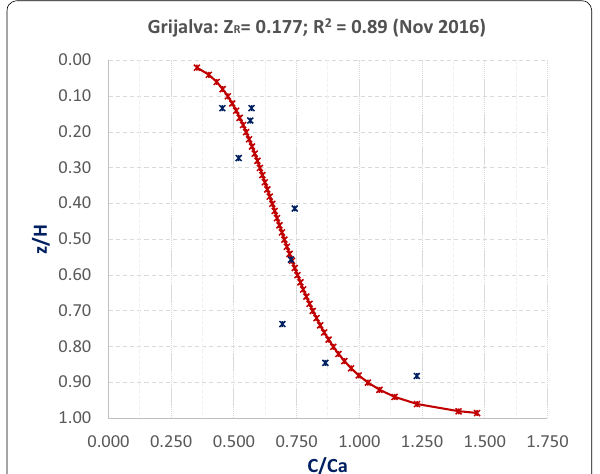
Fig. 5 Suspended sediment concentration profile for the Grijalva